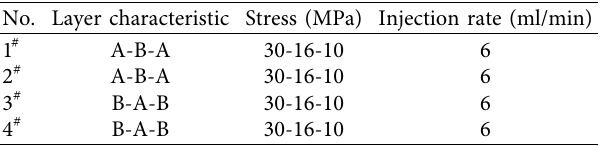
Table 2: Experimental parameters of layered conglomerate hy- draulic fracturing.